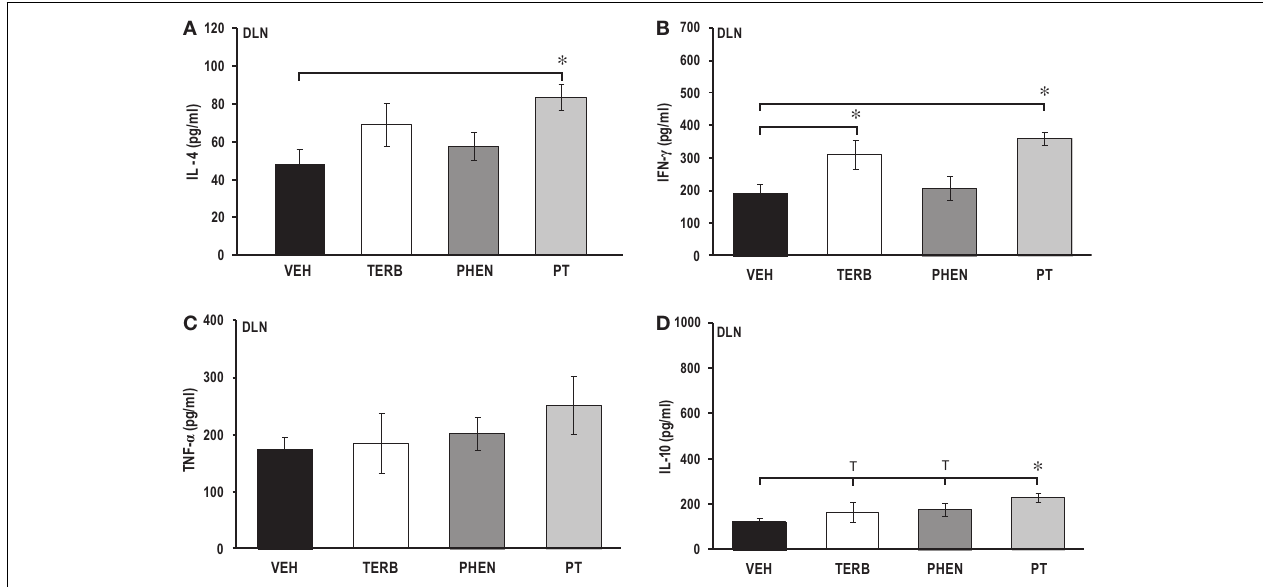
by treatment with PT over that found inVEH controls. N = 8. * p < 0.05. (B) IFN- γ concentrations were higher inTERB- and PT- than withVEH-treated that seen withVEH treatment. N = 8. * p < 0.05.